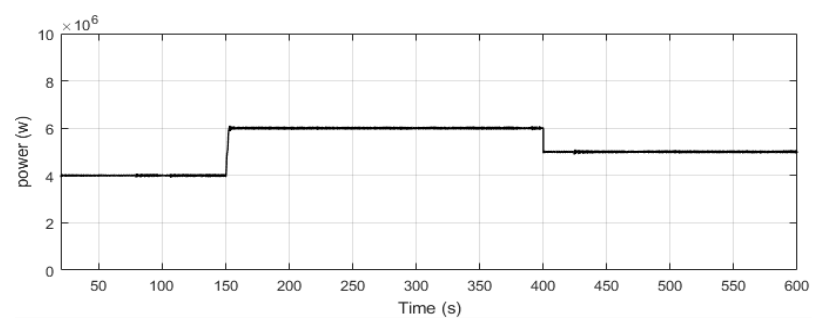
Figure 17. The response of the system with changing TSO order.